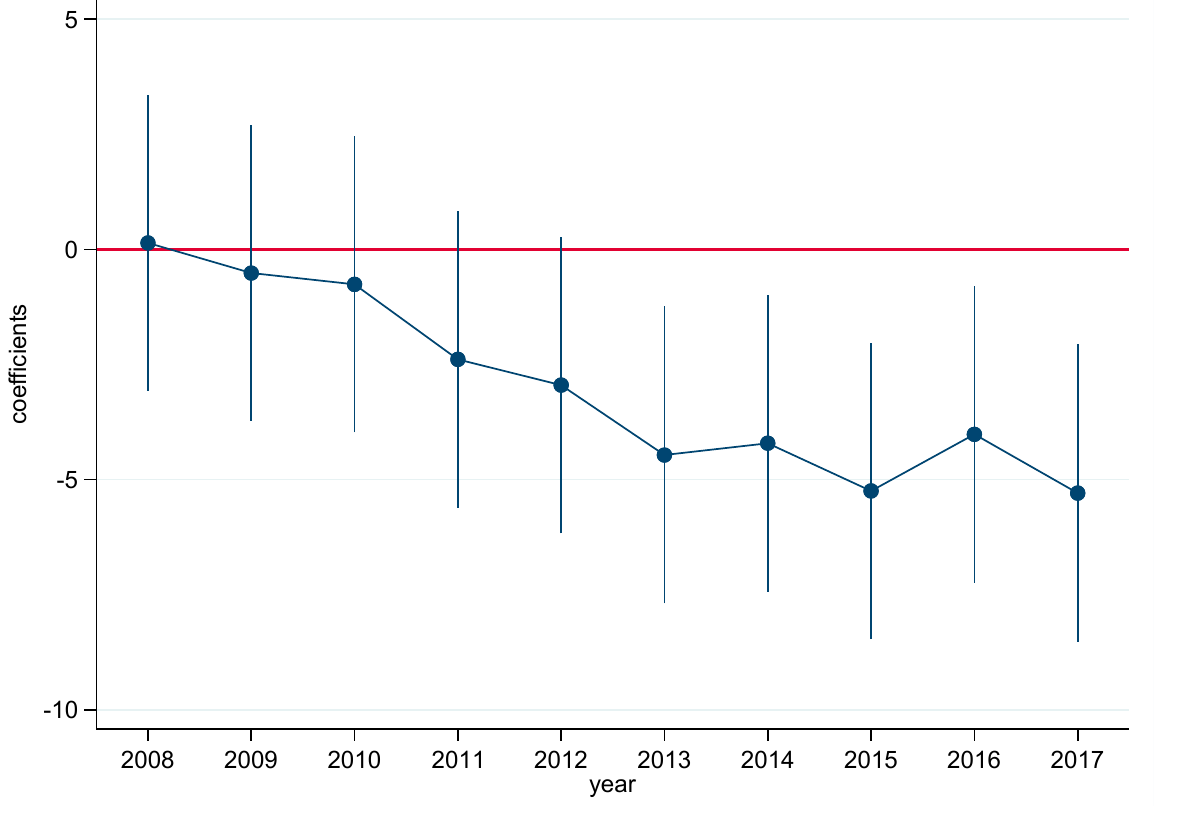
Figure 2. Box plot of parallel trend test.